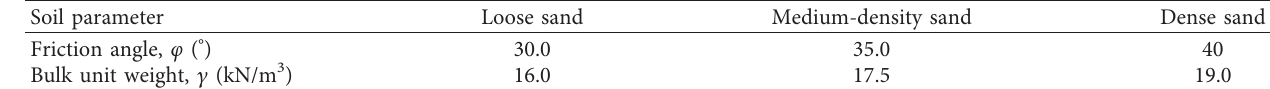
Table 2: Summary of soil